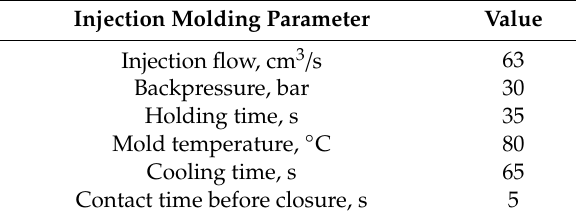
Table 2. Fixed injection molding parameters for the overmolding of the T-joint specimens.